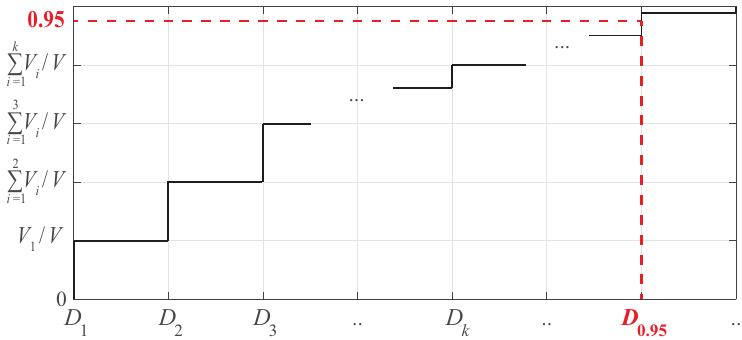
Figure 6. Definition of the global damage D 0.95 based on 95%